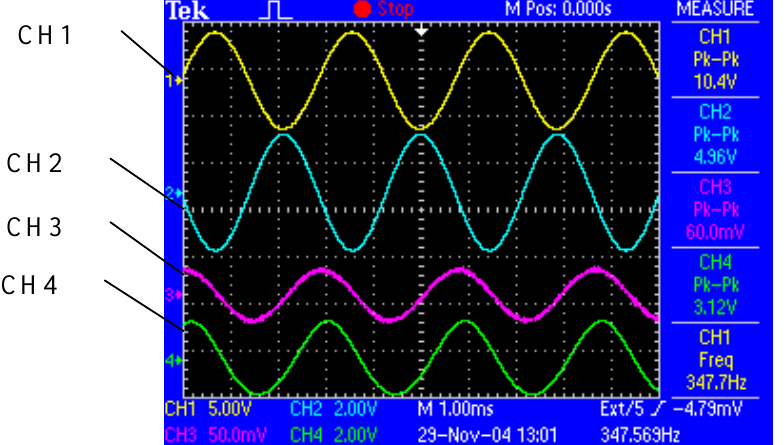
Figure 9. Sensing tests of 6.5 m m-thick PZT film at 347 Hz recorded by the oscilloscope (CH1: excitation from the function generator; CH2: amplified driving signal; CH3: signal of the PZT film; CH4: reference signal from the photonic